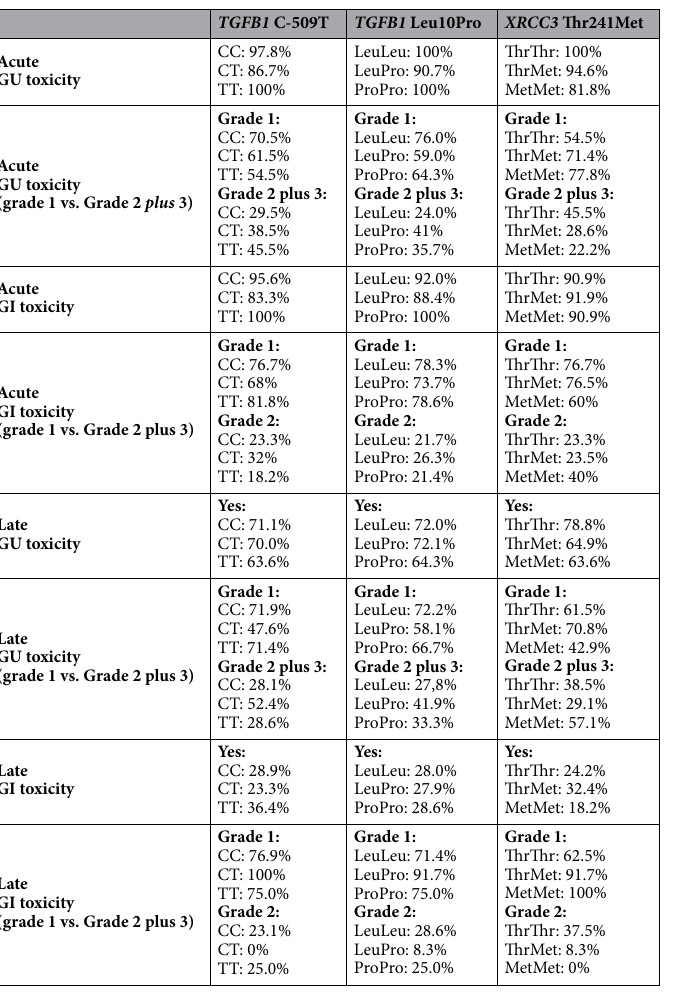
Table 3. Distribution of acute and late RT-induced GU or GI toxicity between patients with genotypes of TGFB1 C-509T, TGFB1 Leu10Pro and XRCC3 Thr241Met. GU- genitourinary; GI-